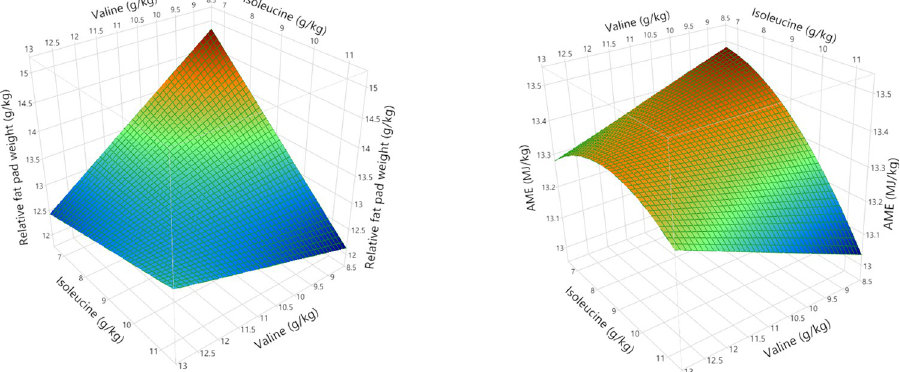
Fig 6. Response surfaces showing the relationship between dietary digestible valine and isoleucine on relative fat pad weights (28 days post-hatch) and apparent metabolisable energy (AME) from 24 to 27 days post-hatch.